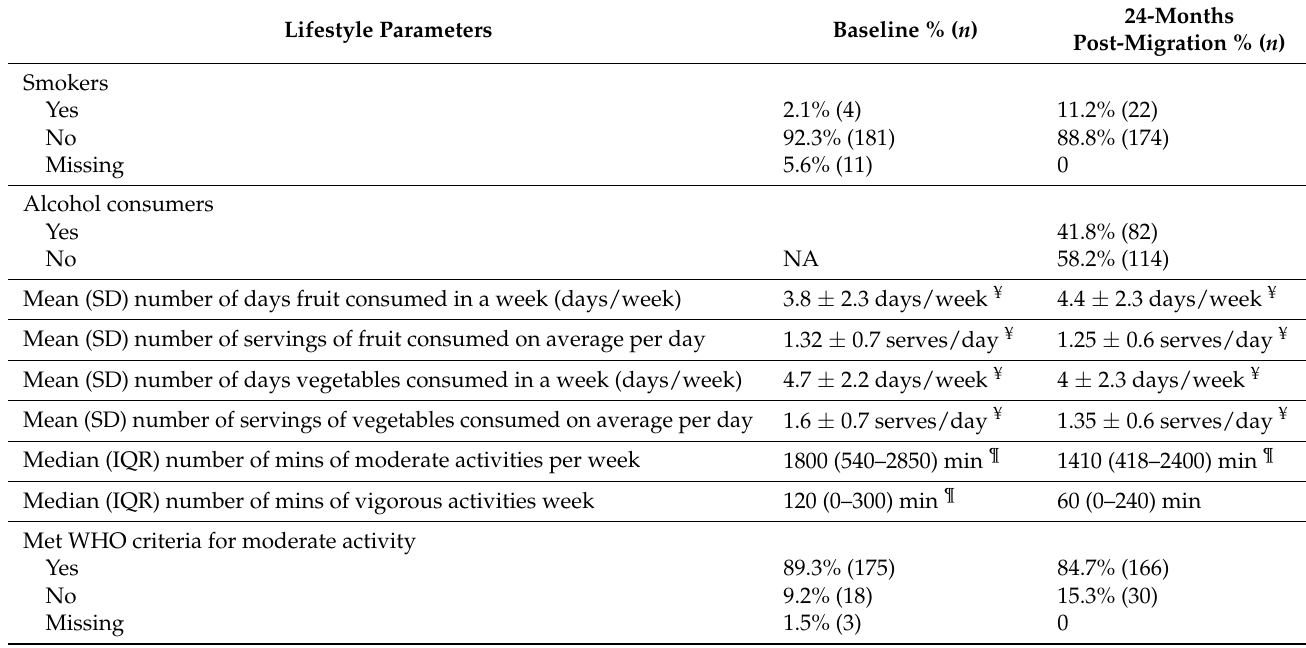
Table 3. Lifestyle parameters at baseline and 24-months post-migration ( n =